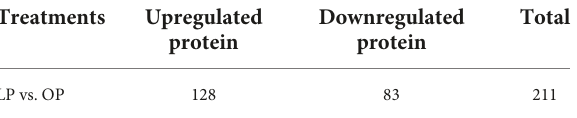
TABLE 3 Differential protein identification results of phosphorus-free side of dual-root soybean roots.